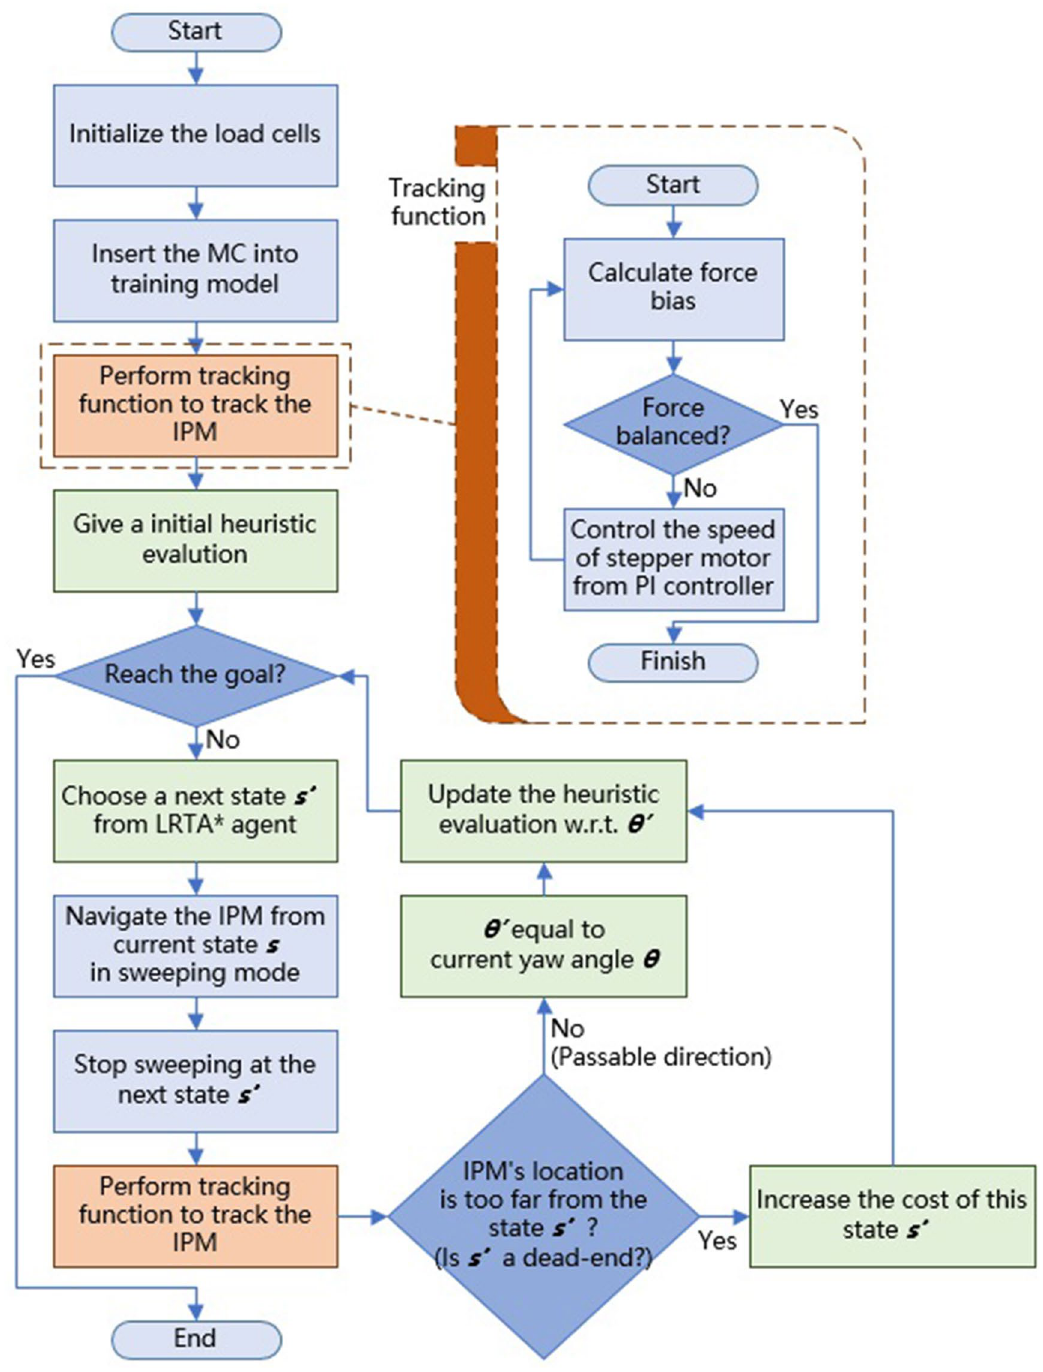
Figure 9. The flowchart of the autonomous navigation in the MAC